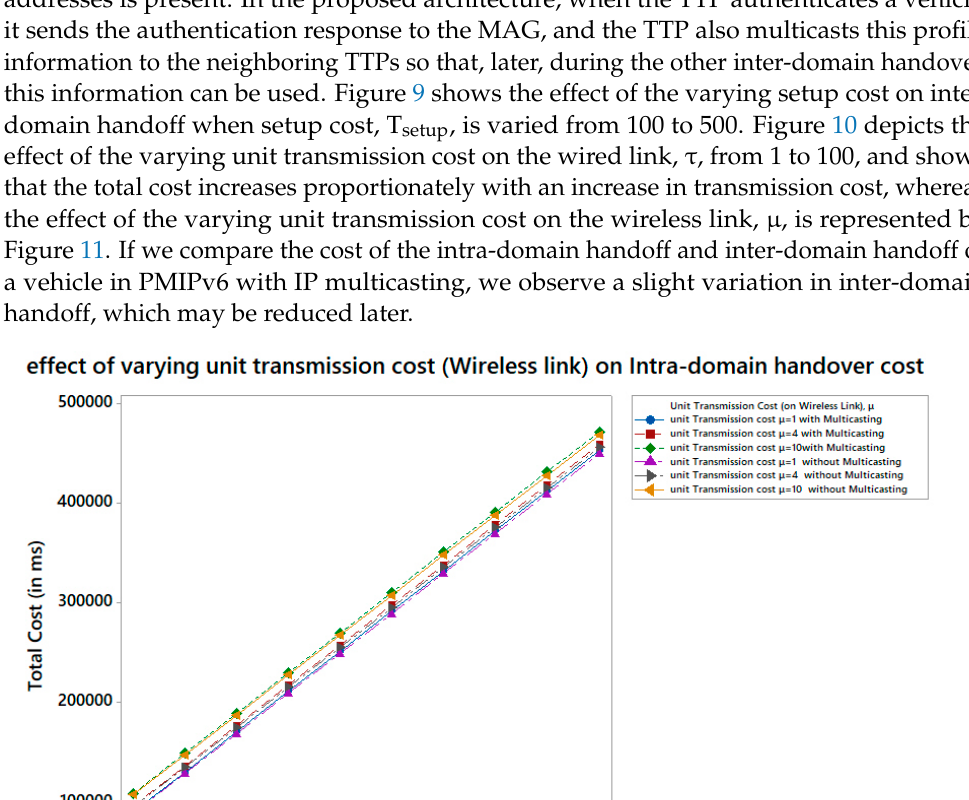
Figure 7. Effect of varying unit transmission cost (wired link) on intra-domain handoff .